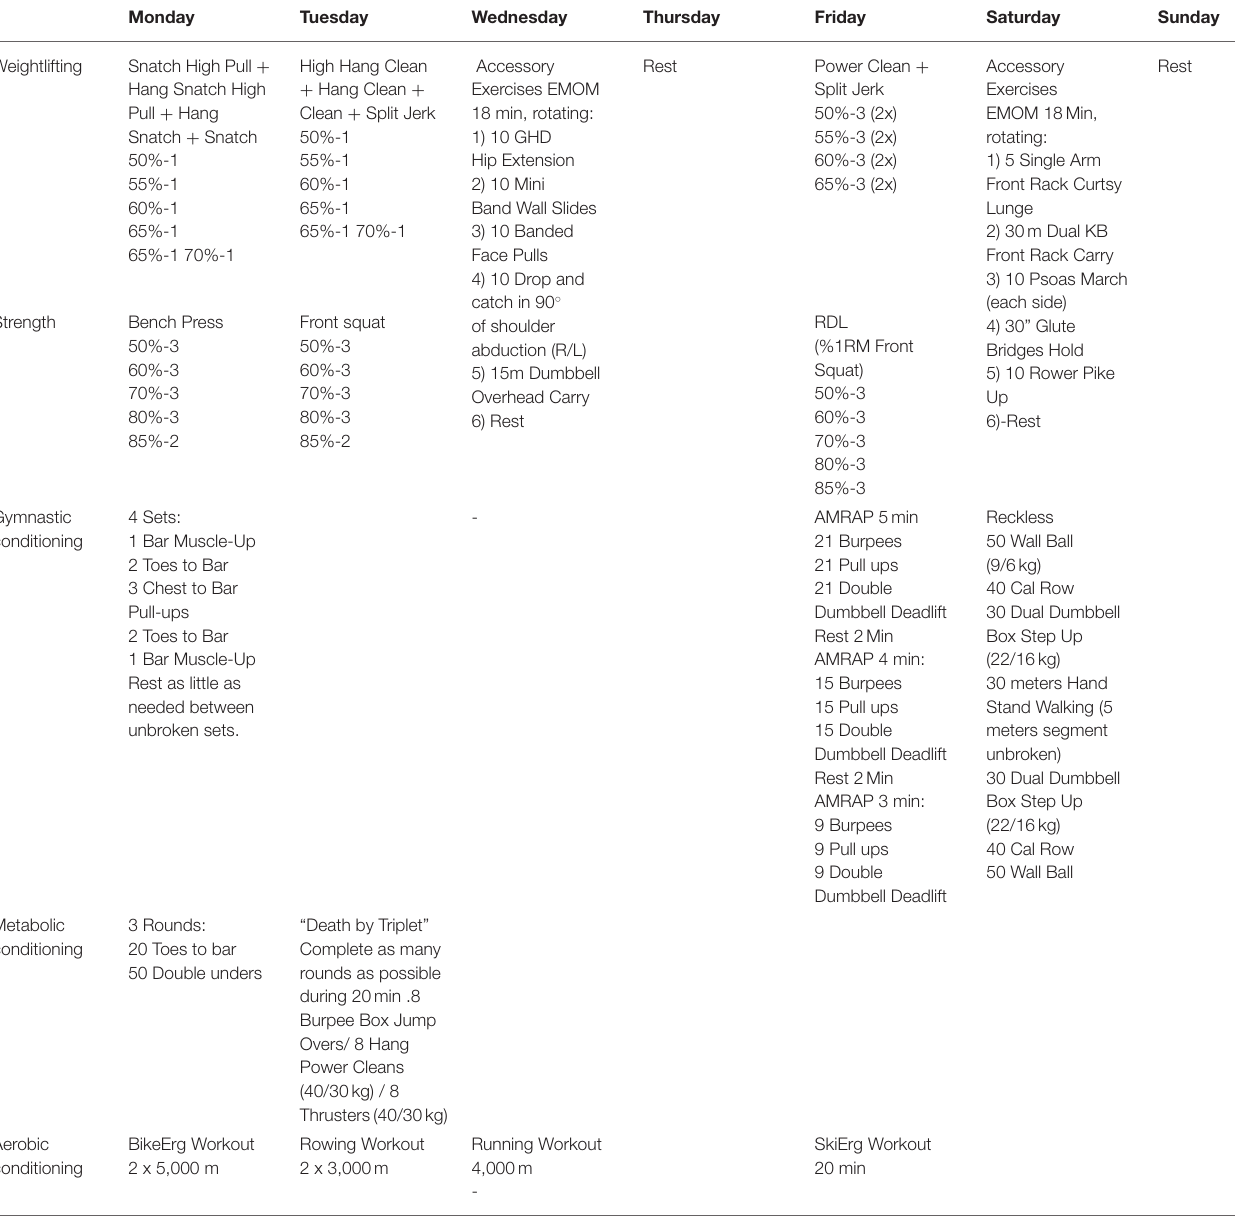
TABLE 2 | Functional fitness training in a week (designed for one